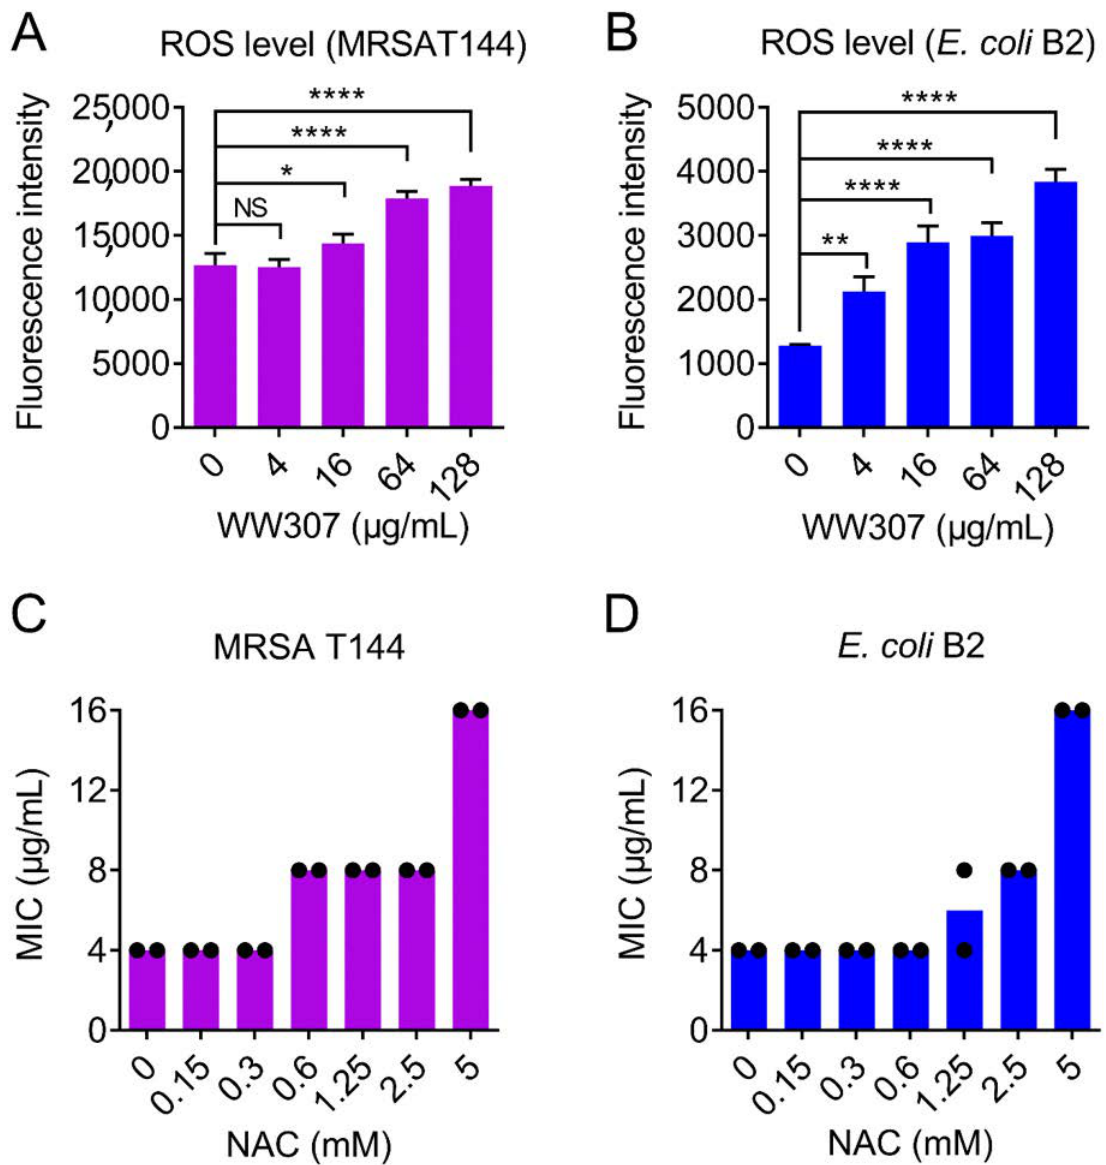
Figure 9. WW307 triggers the production of ROS in MRSA T144 and E. coli B2. The production of ROS of MRSA T144 ( A ) and E. coli B2 ( B ) was determined by 2’,7’-dichlorodihydrofluorescein diacetate (DCFH-DA, excitation at 488 nm and emission at 525 nm). Before fluorescence assay, probe-labelled cells were incubated with WW307 at 37 ◦ C for 1 h. ( C , D ) N -acetylcysteine (NAC) supplementation abolished the antibacterial activity of WW307 against MRSA T144 and E. coli B2. In A and B, all data were presented as mean ± SD, and the statistical significance was determined by non-parametric one-way ANOVA (NS, not significant; * p < 0.05, ** p < 0.01, **** p <